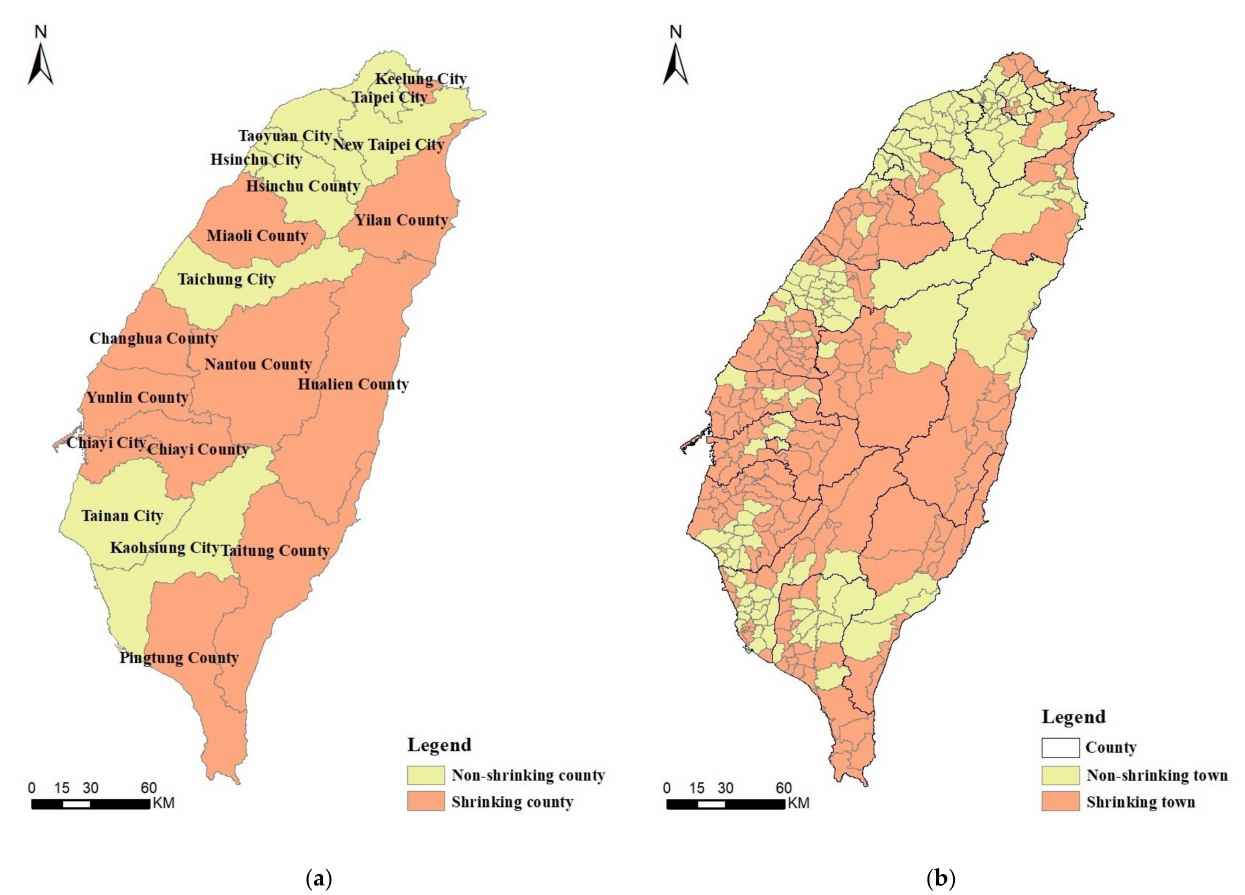
Figure 3. Spatial distribution of shrinking counties and towns: ( a ) shrinking counties; ( b ) shrinking towns.